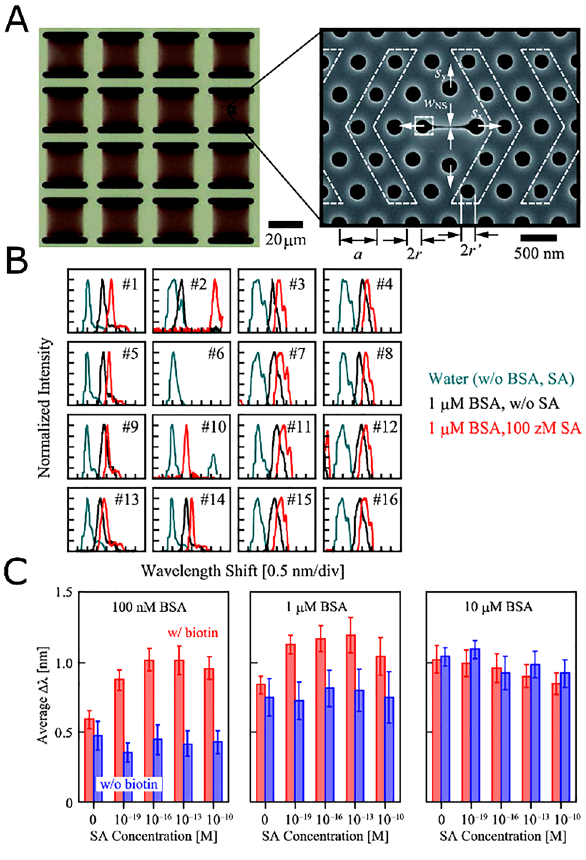
Figure 5: Biological sensing of proteins. (A) Schematic of 16-element photonic crystal uncoupled array